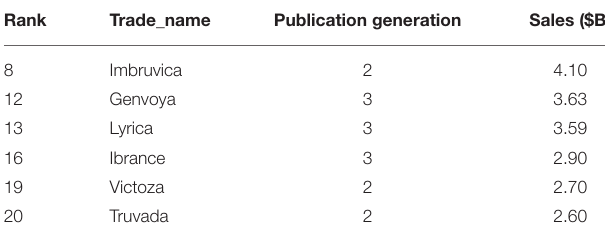
TABLE 2 | U.S. sales in 2018 for top-selling drugs that were linked to NIGMS-supported